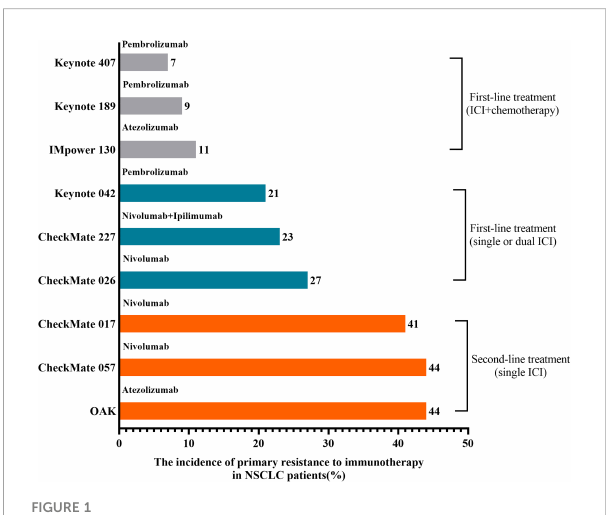
FIGURE 1 The incidence of primary resistance to immunotherapy in NSCLC patients. The highest incidence of primary resistance to ICIs was found in patients treated with ICIs as second-line treatment after chemotherapy failure, while the lowest incidence was found in NSCLC patients previously treated with immunotherapy plus